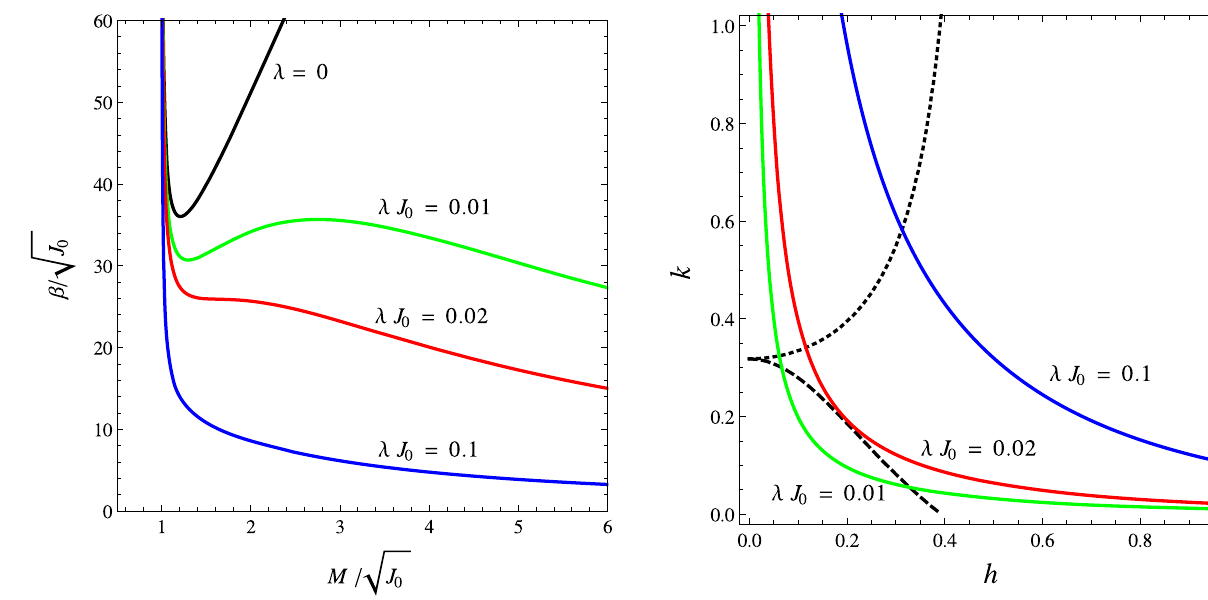
Fig. 6 Curves of the conjugate variable β( M ) at fixed J in the micro- canonical treatment. The λ = 0 (black) curve represents the stability curve of the black hole in the standard thermodynamic approach, while the λ J 0 = 0 . 01 (green), λ J 0 = 0 . 02 (red) and λ J 0 = 0 . 1 (blue) curves are the stability curves within the Rényi approach. No vertical tangent occurs in either case. By rotating the figure clockwise with π bility curves of the canonical treatment can be obtained, i.e. − M (β) at fixed J . In this case, the λ J 0 = 0 . 01 (green) curve has two vertical tan- gents denoting the loss and the recovery of stability. In this scenario, up to three black holes with different mass-energy parameters can coexist at a given temperature